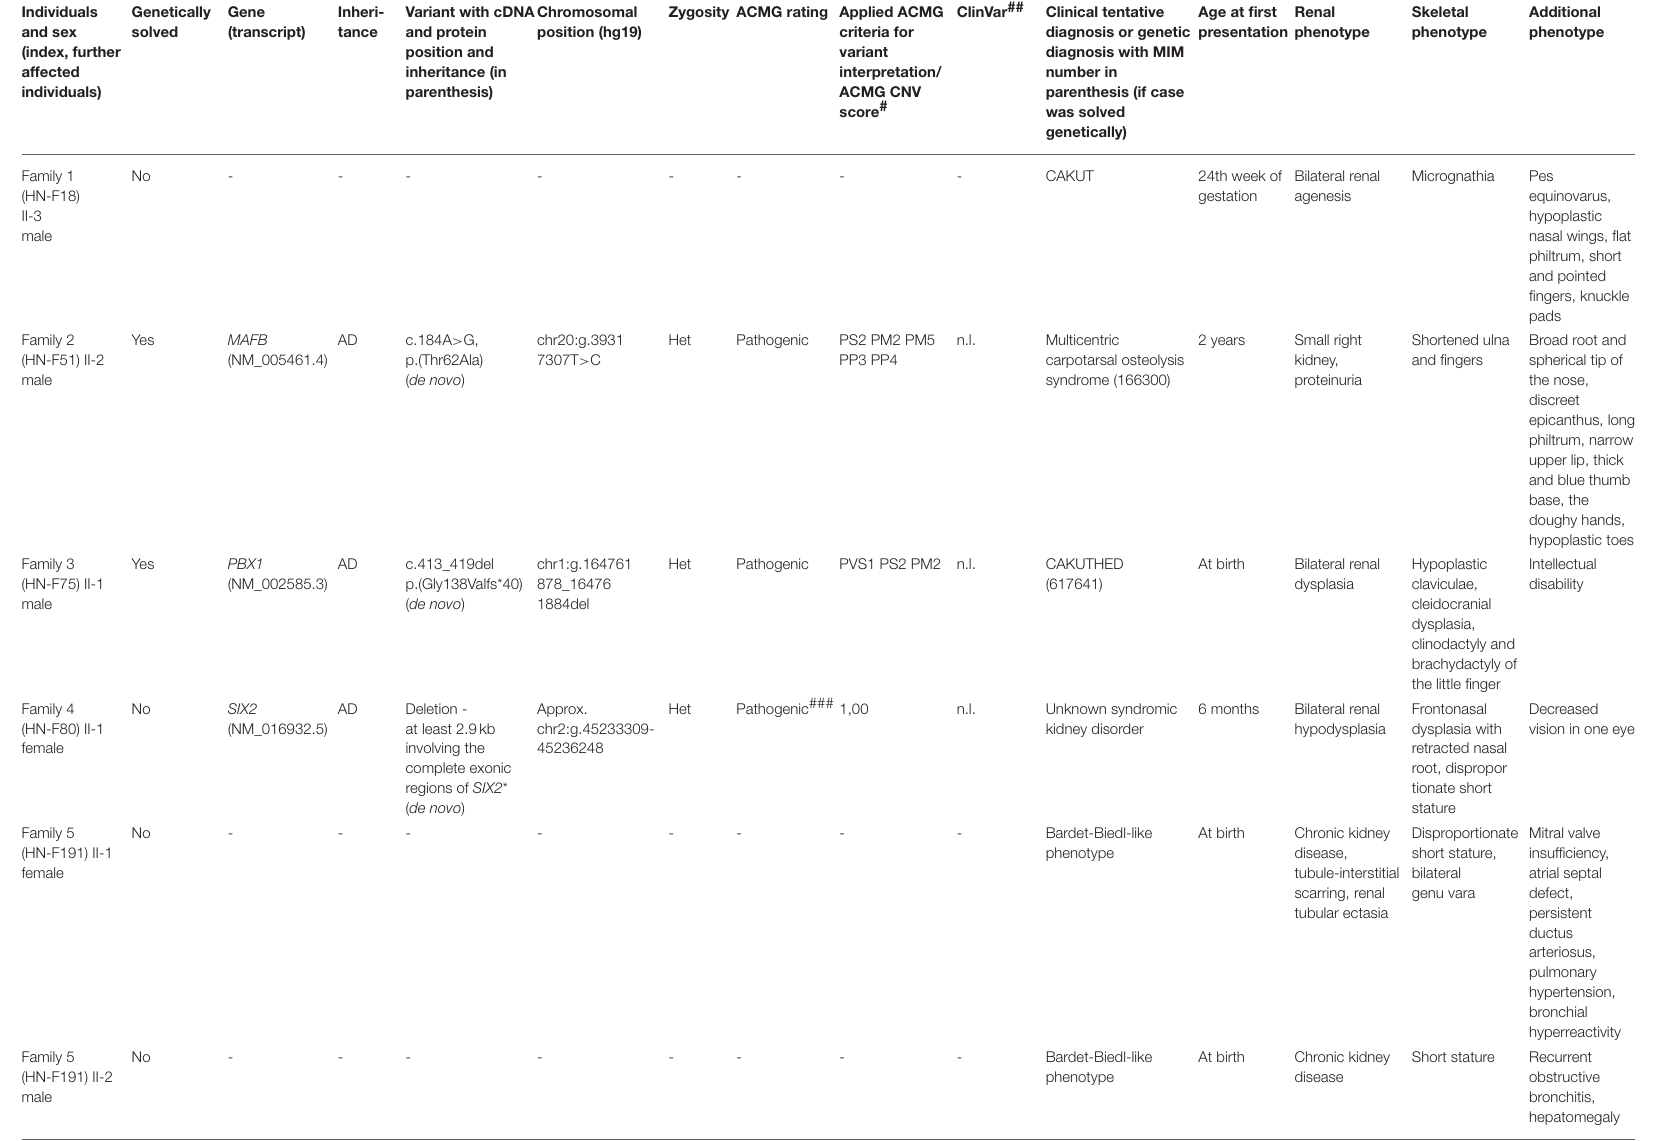
TABLE 1 | Overview of the index cases and also affected siblings including a detailed description of phenotype and genotype. Individuals and